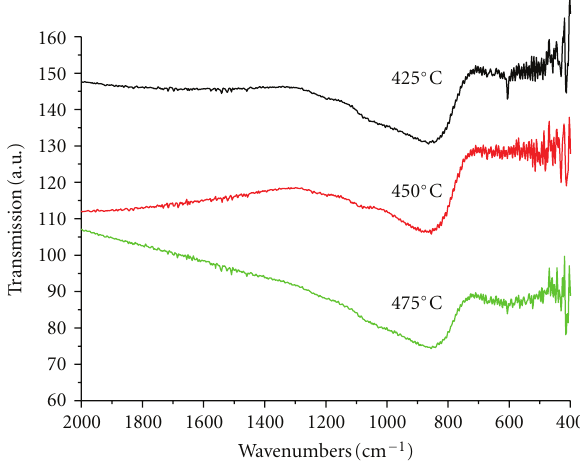
Figure 6: FTIR transmission spectra of SiN x films deposited at 425 ◦ C, 450 ◦ C, and 475 ◦ C, respectively.